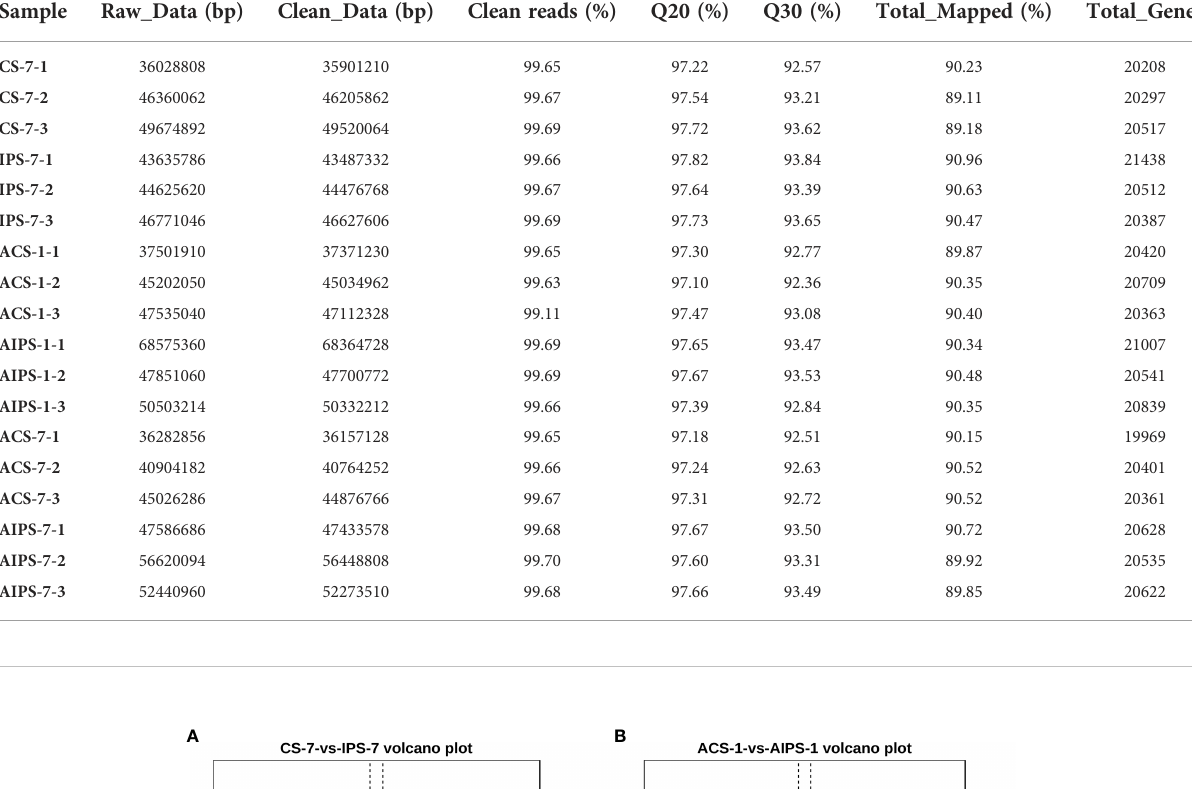
TABLE 2 Summary of transcriptome data from splenic